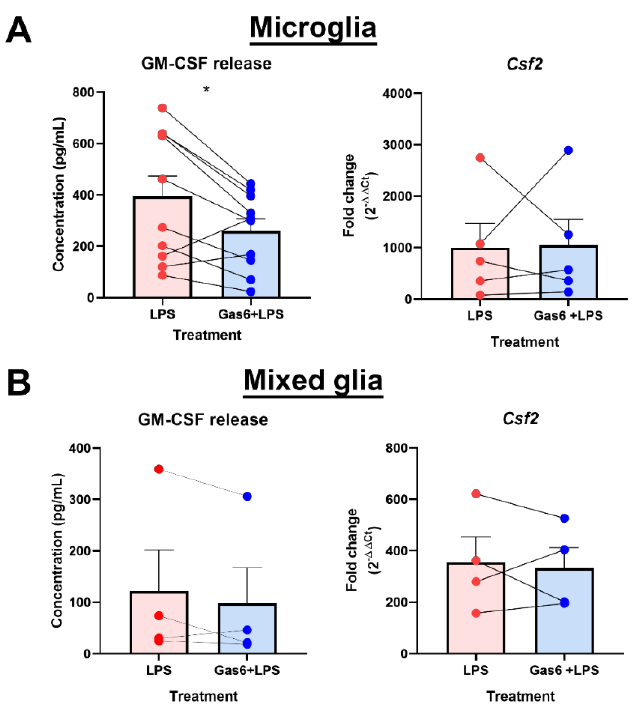
Figure 4. Gas6 supresses the LPS-upregulated GM-CSF protein release by microglia. RT-qPCR and ELISA were used to measure the gene expression and protein release of GM-CSF from: ( A ) pure microglial cultures or ( B ) mixed glial cultures after 48-h LPS treatment (10 ng/mL) with or without 1-h pre-treatment with Gas6 (1.6µg/mL), the Gas6 remaining throughout. Gene expression data shows fold change (2 −ΔΔCt ) and protein release data displays GM-CSF protein concentration (pg/mL). Non-treated microglia had a protein concentration of 0 pg/mL and mixed glia had baseline levels of 0–2 pg/mL (data not shown). Statistical significance was determined using Friedman’s tests for ELISA data or Wilcoxon signed-rank tests for RT-qPCR data with p < 0.05 ( n = 4–10 independent experiments on separate cultures). * p < 0.05 .